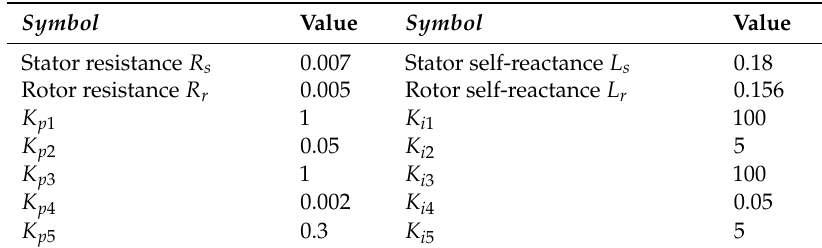
Table A2. Parameters of Doubly Fed Induction Generator (DFIG)